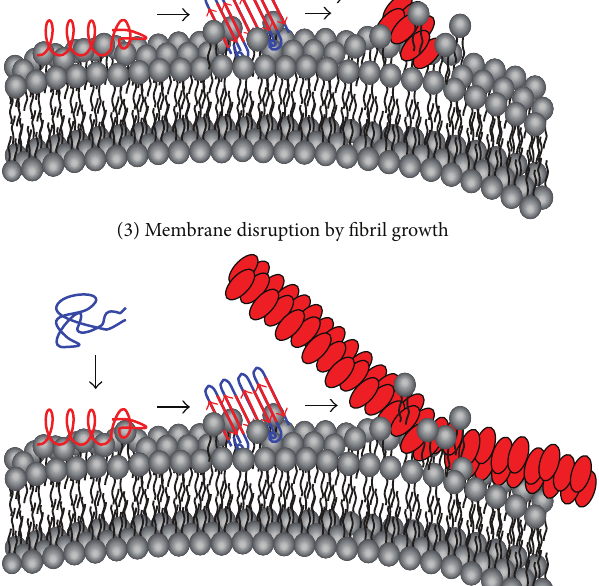
Figure2:Threedifferent,butnotexclusiveproposedmechanismsof membrane disruption by hIAPP and its aggregation. Upon binding of hIAPP with the membrane, formation of 𝛼 -helical structure within monomeric hIAPP is favored due to its amphipathic nature. Initial irritation of the membrane integrity occurs. Self-assembly of hIAPP results in the formation of 𝛽 -sheets and causes deeper membrane disruption. The further formation of oligomers leads to enhanced membrane disruption and disintegration either by forming pores within the lipid bilayers (1) or simply by extracting lipids from the membrane (2). At a later stage, the growth of fibrils (3) has also been observed to be responsible for membrane